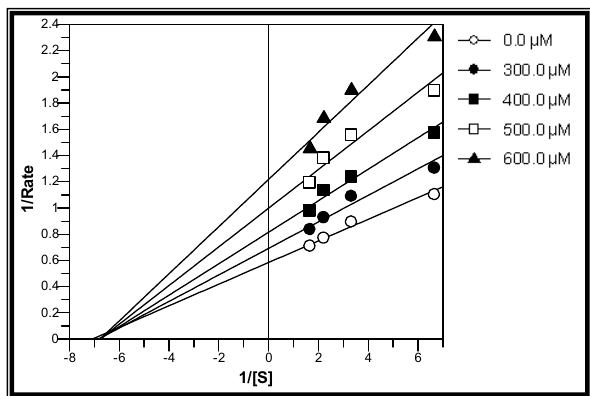
Figure 1. Rate of the reaction vs substrate at different concentrations of 1.